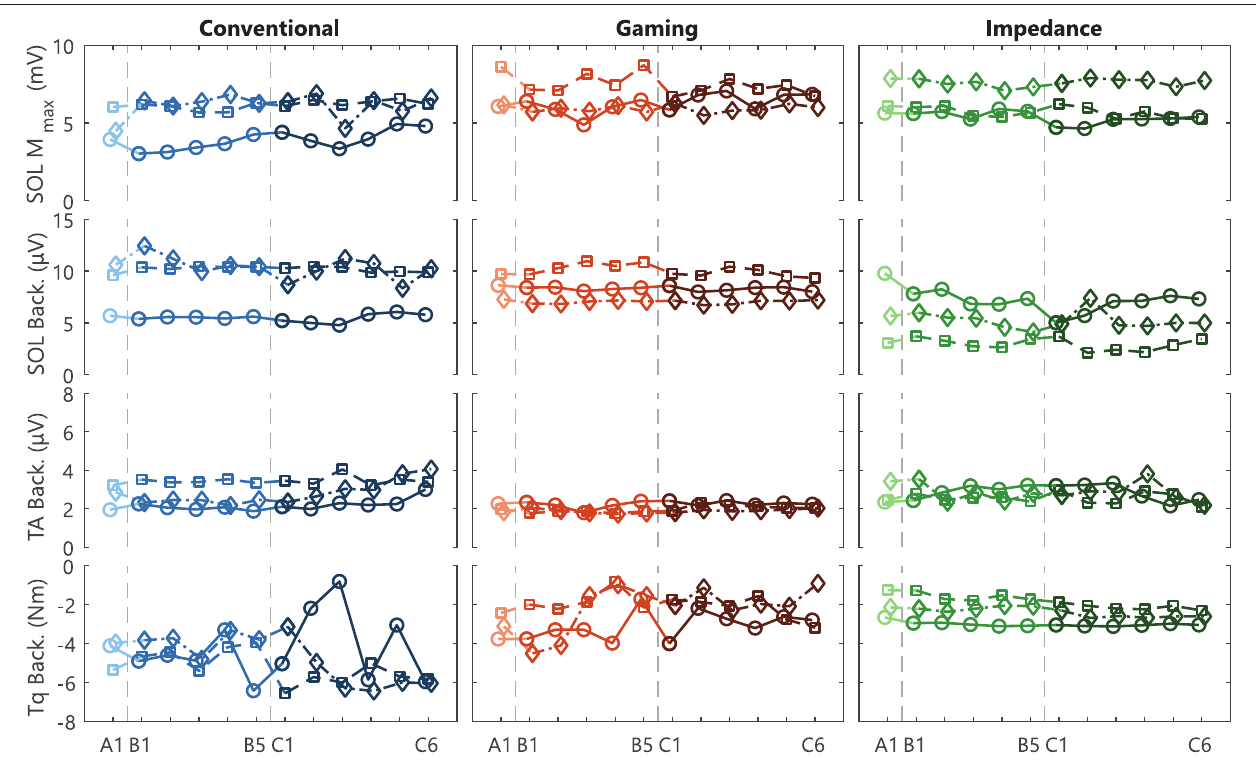
FIGURE 3 | Steadiness M max and background activity. Individual participant traces of SOL M max , and SOL, TA, and torque background activity for acclimatization (A1), baseline (B1-5), and conditioning (C1-6) sessions. All variables were required to remain steady throughout data collection. Each data point reflects the average of all blocks (Block 0–3) within a single session. Conventional and Gaming groups received biofeedback on SOL activity, whereas the Impedance group received biofeedback on torque activity. For all groups, TA activity was required to remain at a resting level ( < 7.5 µ V). Each icon (circle, square, and diamond) per group is linked to an individual participant and consistently used across